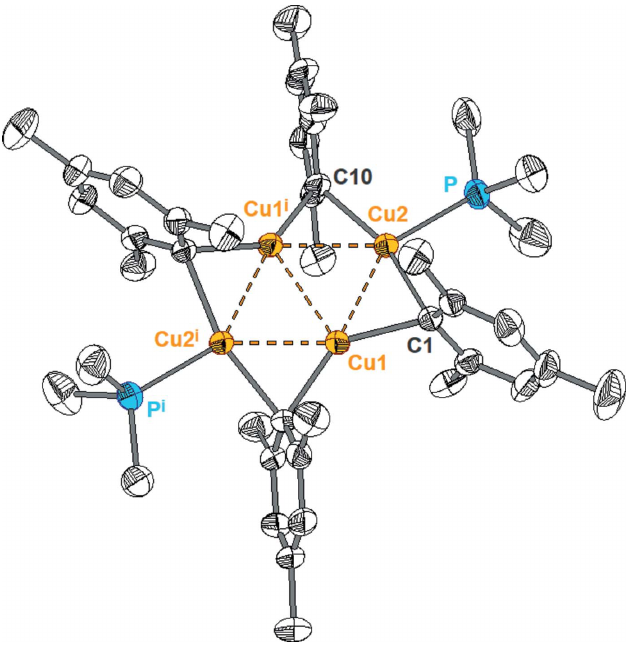
Figure 2 Partial packing diagram for 1 in a view down the crystallographic b axis. 2